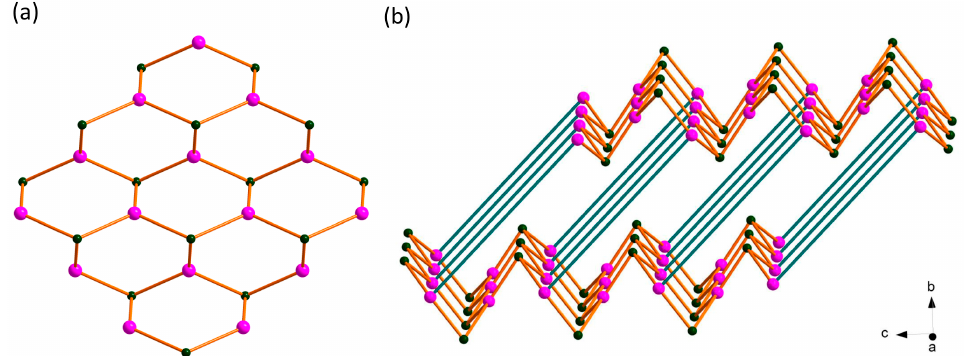
Figure 3. ( a ) View of the three-connected unimodal 2D net of the Co-Me 2 mal layer in 1 and ( b ) (3,4)-connected ins topology of compound 1 .